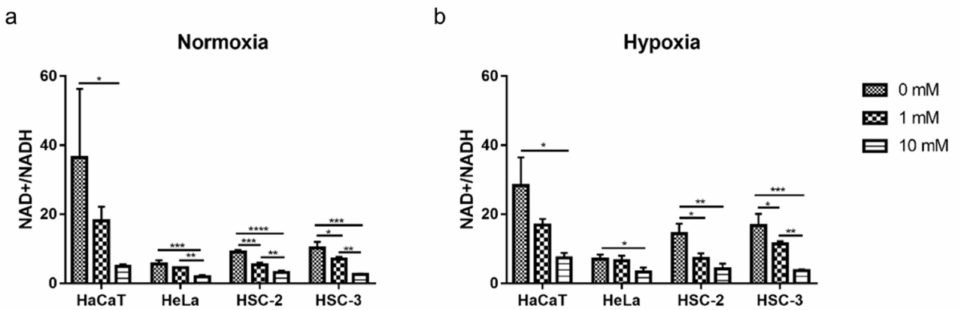
Figure 5. Decreased NAD + /NADH ratio during growth with metformin under normoxia ( a ) and hypoxia ( b ). A one-way ANOVA and Tukey’s test. * p < 0.05, ** p < 0.01, *** p < 0.001, **** p < 0.0001. All experiments were independently performed in triplicate.